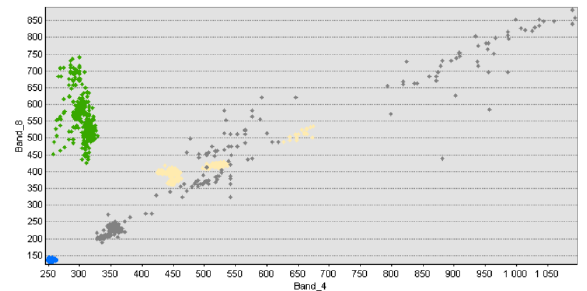
Figure 7. Example of scatterogram for band 3 and 4 showing spectral distribution of the signatures: grey infrastructure (grey), bare soil (beige), vegetation (green), water (blue).